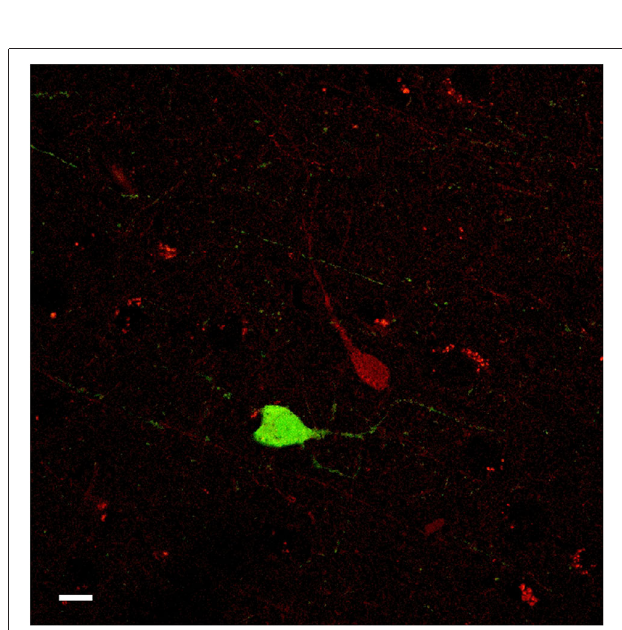
FIGURE 11 | Confocal microscope images of PV-ir (green), and CR-ir (red) neurons in the human claustrum . No co-localization was observed. Scale bar = 10 µ